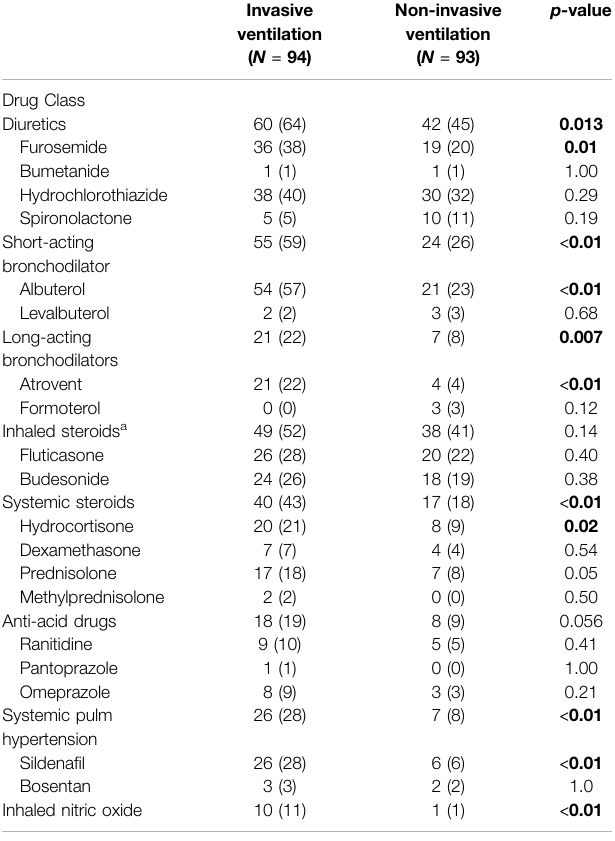
TABLE 2 | Point Prevalence of drug exposures by ventilation group. Invasive